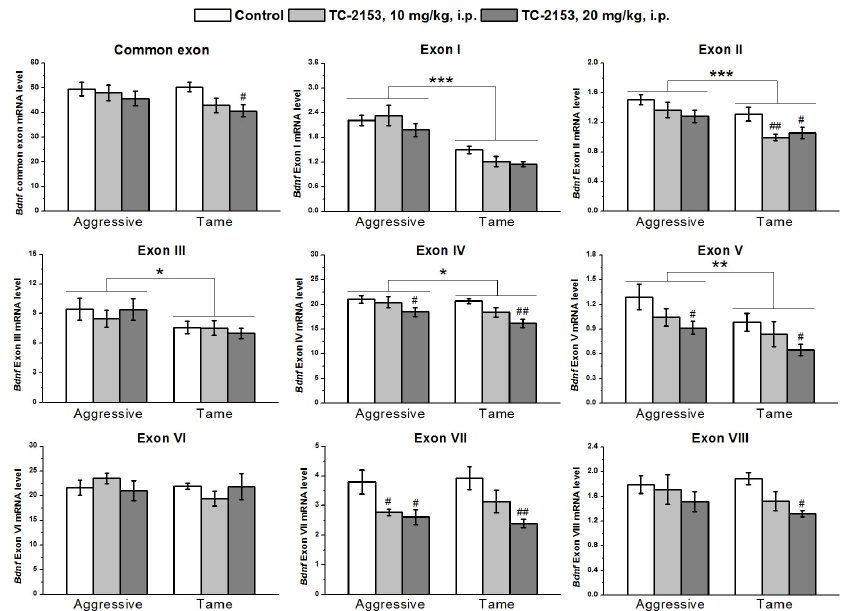
Figure 4. Effects of acute administration of vehicle (control) or TC-2153 at a dose of 10 or 20 mg/kg on mRNA levels of Bdnf (brain-derived neurotrophic factor) regulatory exons I–VIII and coding (common) exon IX in the midbrain of aggressive and tame rats. The expression levels were evaluated as the number of transcript copies per 100 copies of Polr2a mRNA. * p < 0.05, ** p < 0.01, and *** p < 0.001 for the genotype effect; # p < 0.05 and ## p < 0.01 in comparison with the control group (5–7 animals per group).